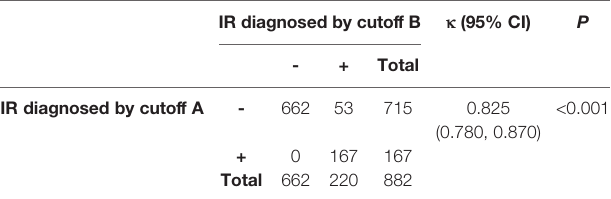
TABLE 3 | Concordance between the different homeostasis model assessment of insulin resistance cutoff values used in diagnosing insulin resistance.